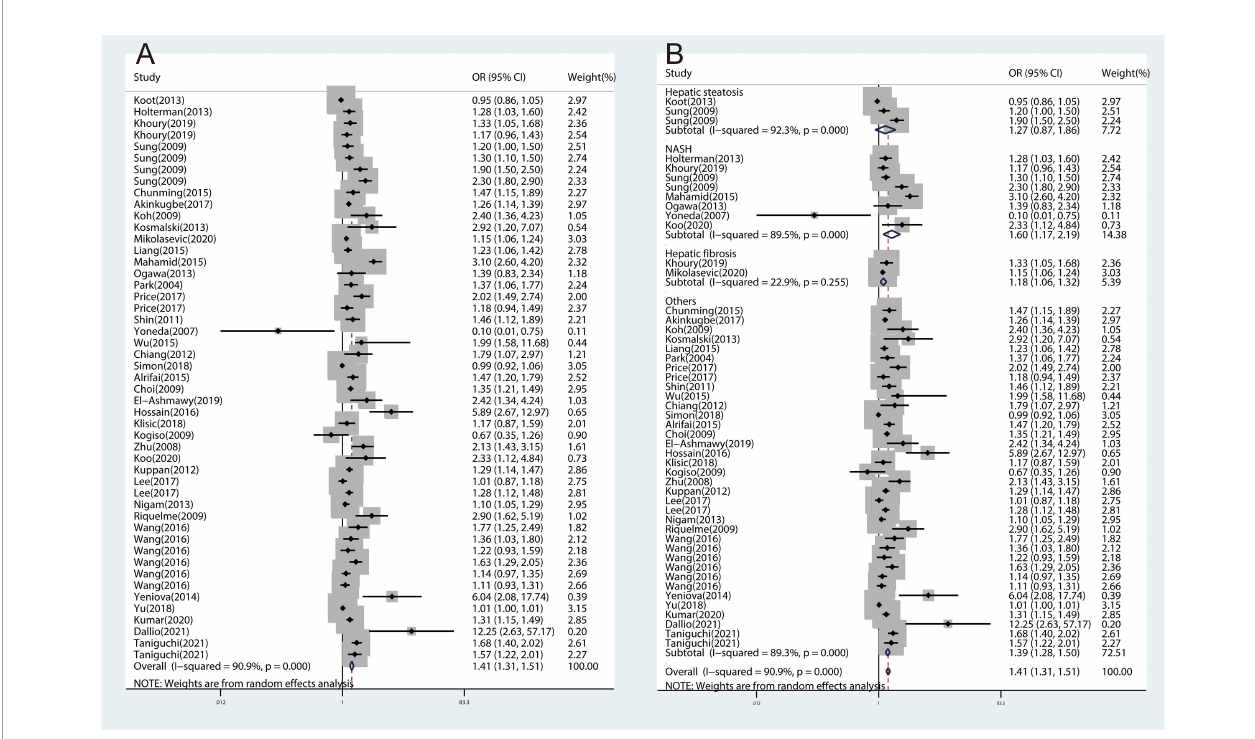
( Figure 3D ) and NAFLD. We did not fi nd signi fi cant associations between IFN- g , IGF-II, IL ‐ 2, IL ‐ 4, IL ‐ 5, IL ‐ 7, IL ‐ 8, IL ‐ 10, IL ‐ 12, MCP ‐ 1, and TGF- b and NAFLD ( Supplementary Figures 1 – 11 ).